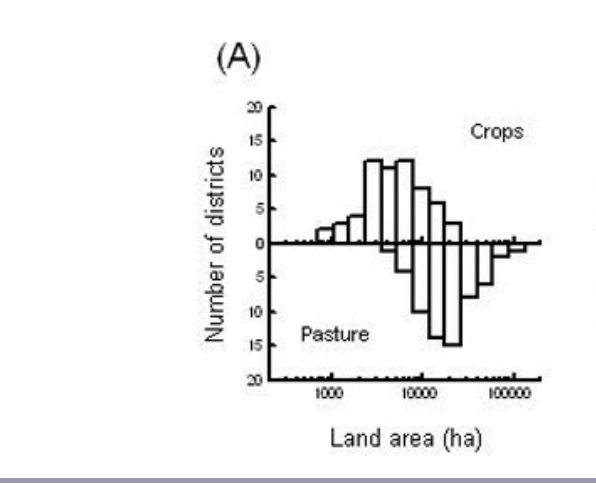
Fig. 6. The number of districts of Panama characterized by (A) land area in crops and pasture and (B) gross income per hectare from crops and pasture. On average, land cover was 3.8 times greater for pasture than for crops, whereas gross income was 6.7 times greater for crops than for